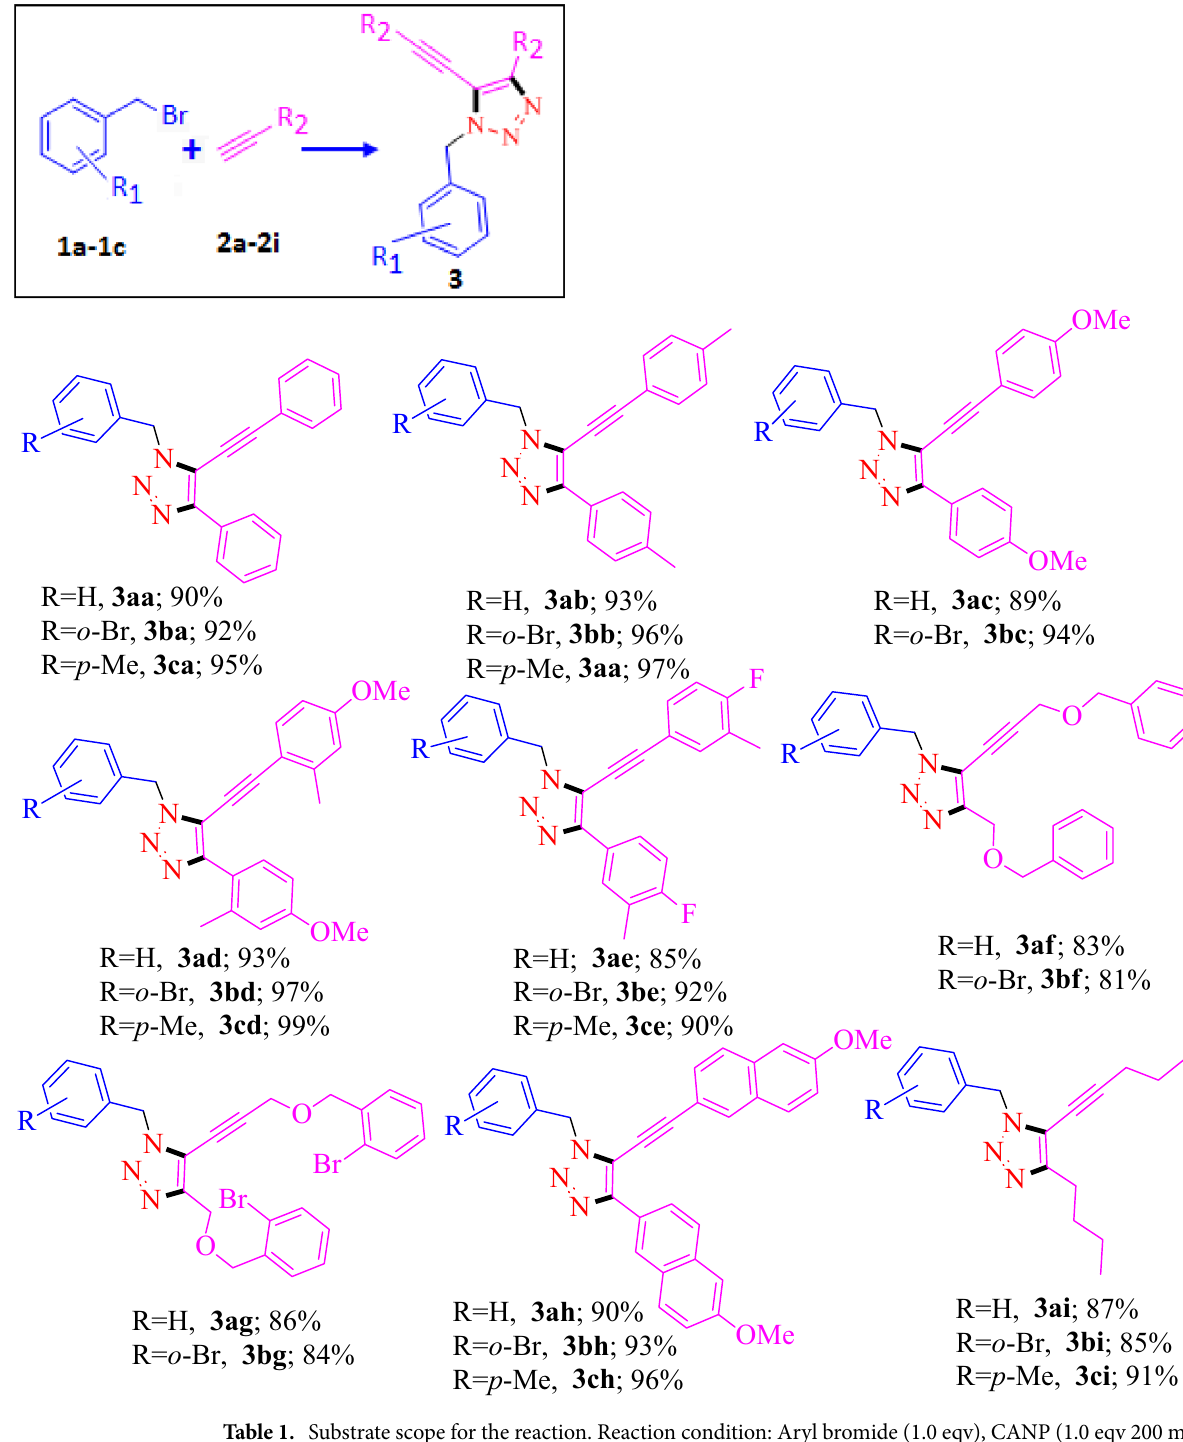
Table 1. Substrate scope for the reaction. Reaction condition: Aryl bromide (1.0 eqv), CANP (1.0 eqv 200 mg), Terminal alkyne (2.0 eqv), MeOH (4 mL), Et 3 N (2 eqv), 25 °C, 3 h. Isolated